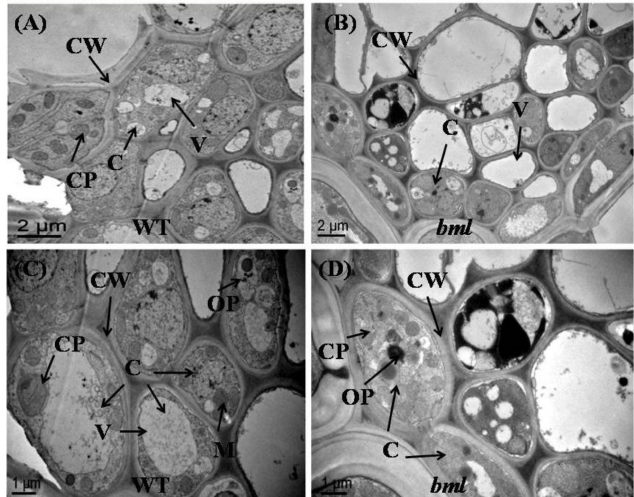
Figure 5. Ultrastructure of mesophyll cells in the middle part of the midrib of the second leaf from the top of bml mutant and WT rice plants at the heading stage. ( A , B ) TEM images of whole leaf mesophyll cells of bml and WT. Bar = 2 µ m. ( C , D ) relatively low magnification view of mesophyll cells of bml and WT. Bar = 1 µ m. C: cell; CW: cell wall; V: vacuole; CP: chloroplast; OP: osmophilic